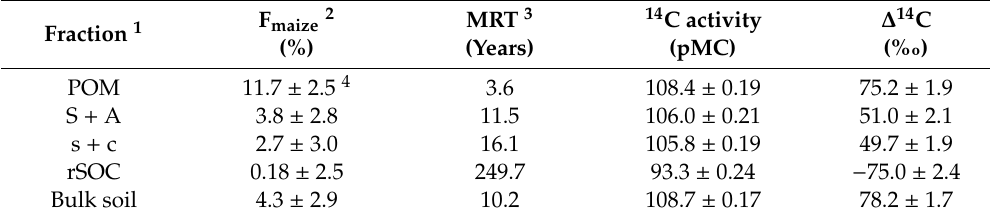
Table 3. Proportion and mean residence time of C derived from the C4 − C (maize residues) input, 14 C activity and ∆ 14 C for the soil fractions separated from the Luvisol